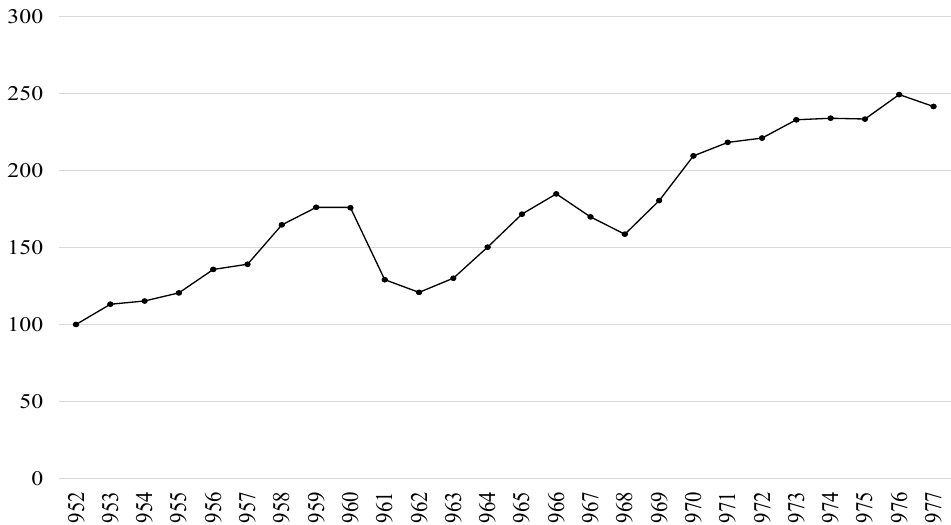
Figure 4. China’s real GDP per capita (yuan) from 1952 to 1977. Notes: Use the real values indexed to 1952 (1952 = 100). Data are from China’s National Bureau of Statistics. It began to make statistics in 1952: